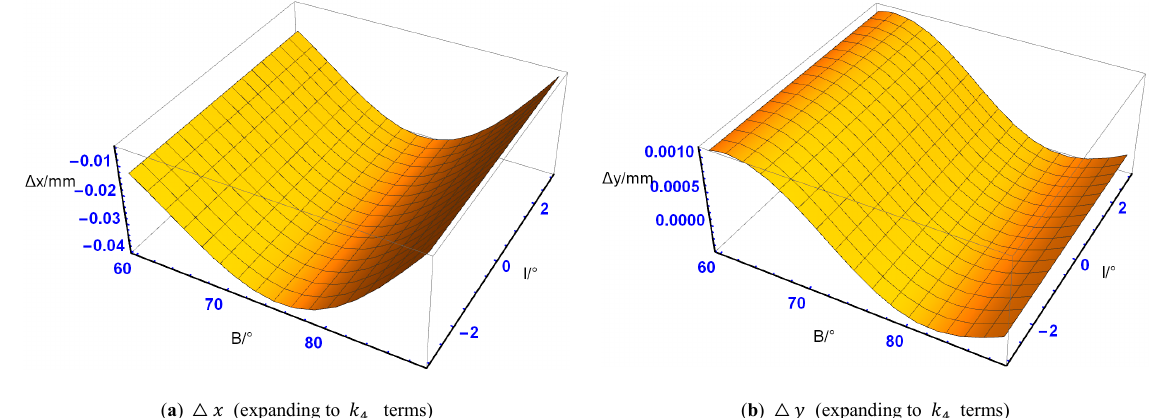
Figure 16. The distribution of ( ∆ x , ∆ y ) when expanding to k 3 terms (based on e ).